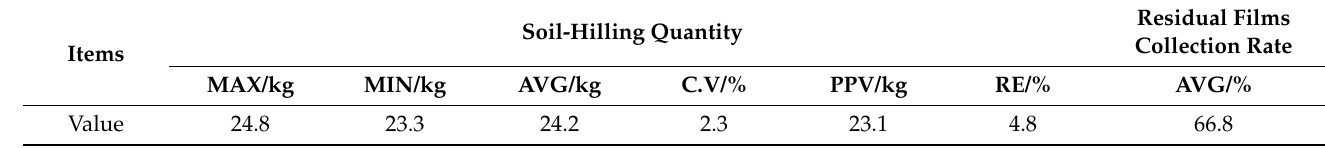
Figure 9. Residual film recovery machine test. ( a ) The test process; ( b ) the test results. Table 5. Measurement results of the field test.